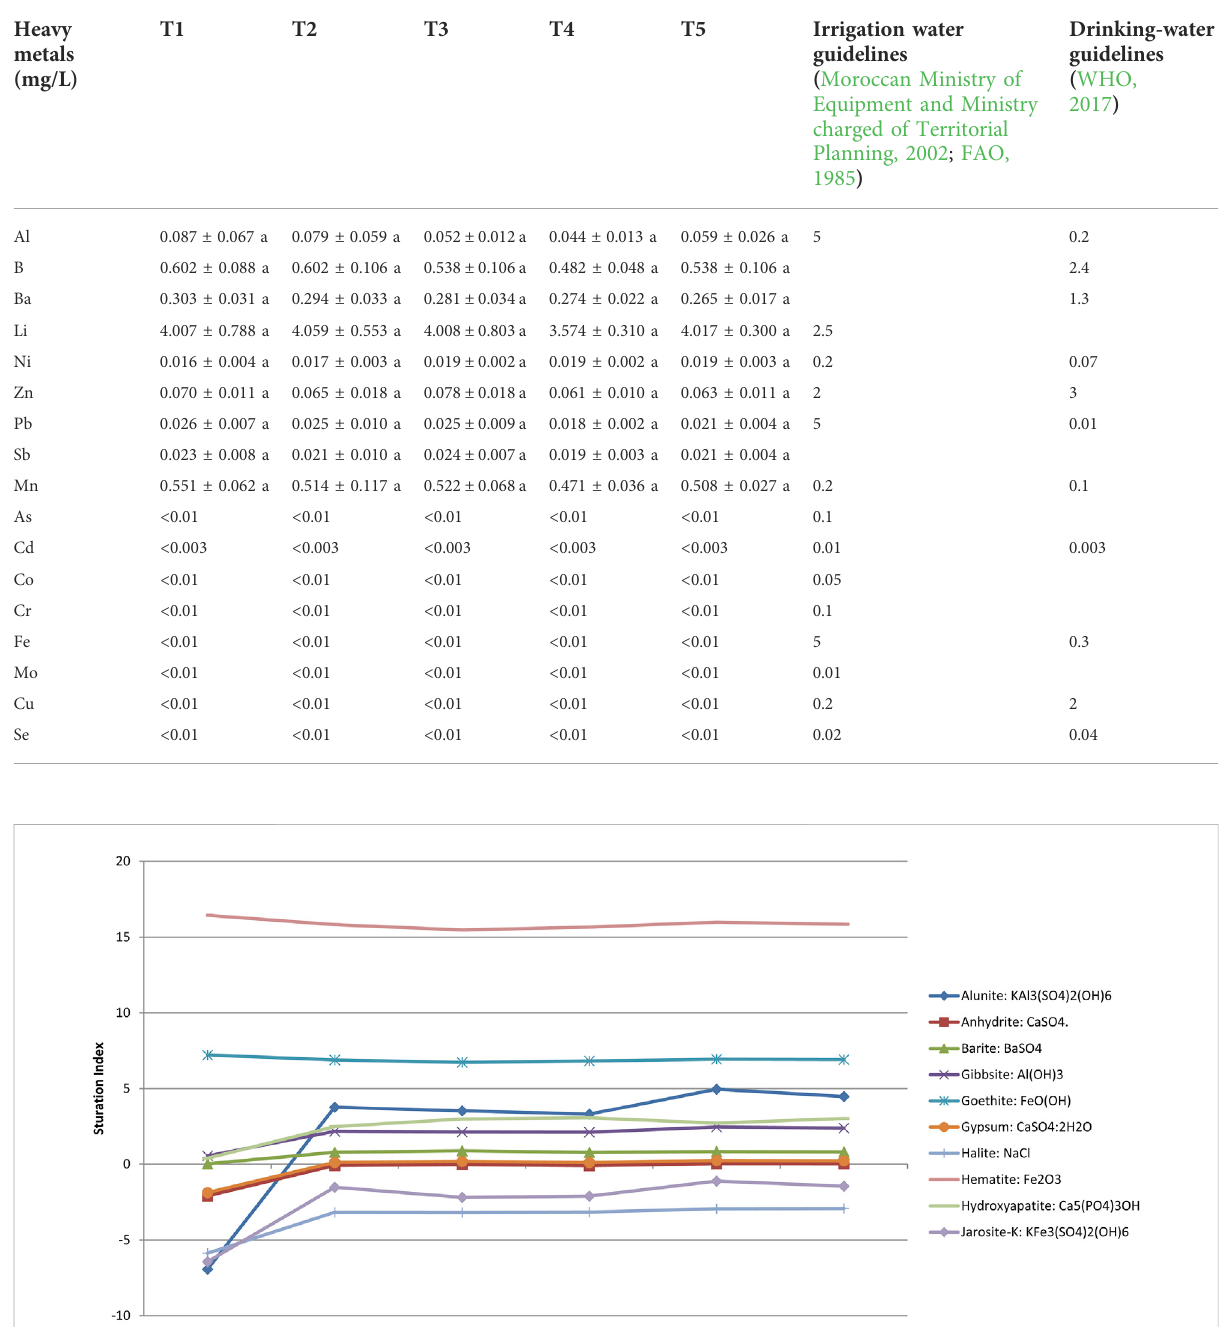
TABLE 7 Heavy metals contents of leachate of Sed El Masjoune soil for different treatments. Same letters in a line series indicate no signi fi cant differences among treatments ( p < 0.05, S-N-K ’ s test).